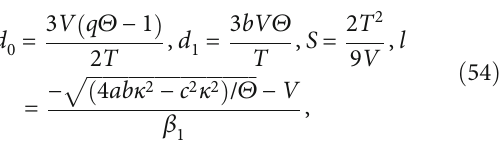
Figure 3: We suggest κ = − 1 , β with γ = 0 : 3 . (b) The 2D graph of u 1,1 ð x , t Þ with distinct values of γ